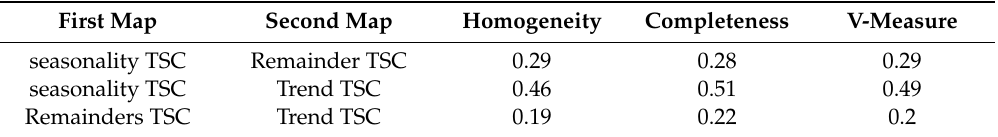
Table 2. V-measure of spatial association between regionalizations among the time-series clustering maps for each pair of time-series components. TSC stands for time-series clustering.